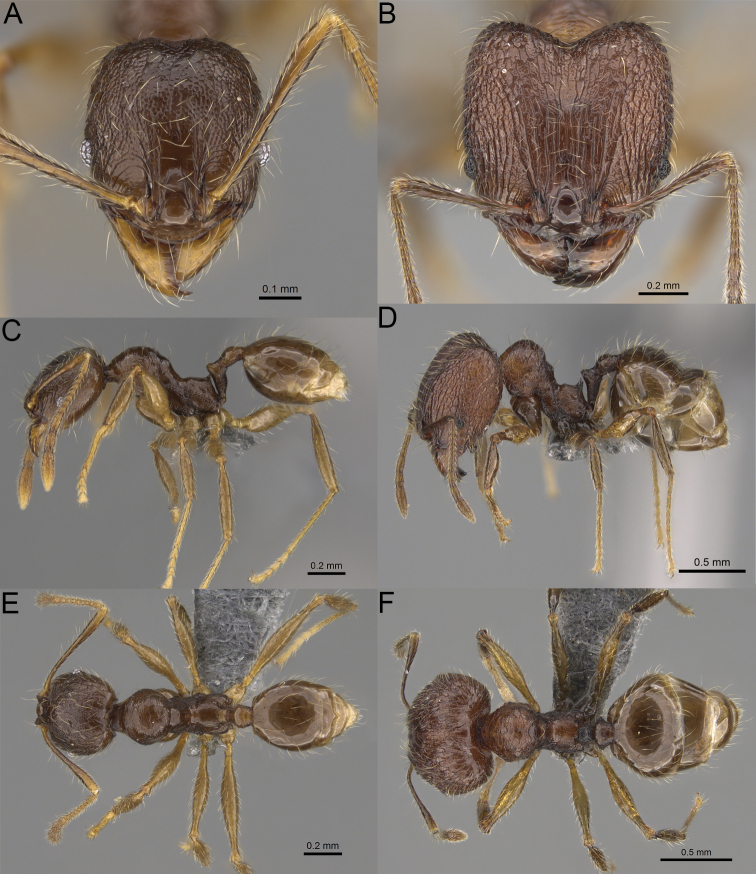
Pheidole
sofia sp. nov., full-face view (A), profile (C), and dorsal view (E) of paratype minor worker (CASENT0923280) and full-face view (B), profile (D), and dorsal view (F) of holotype major worker (CASENT0705626).